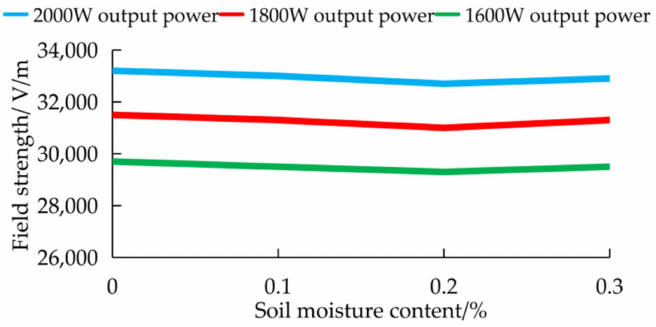
Figure 7. Maximum field strength at the three microwave output power